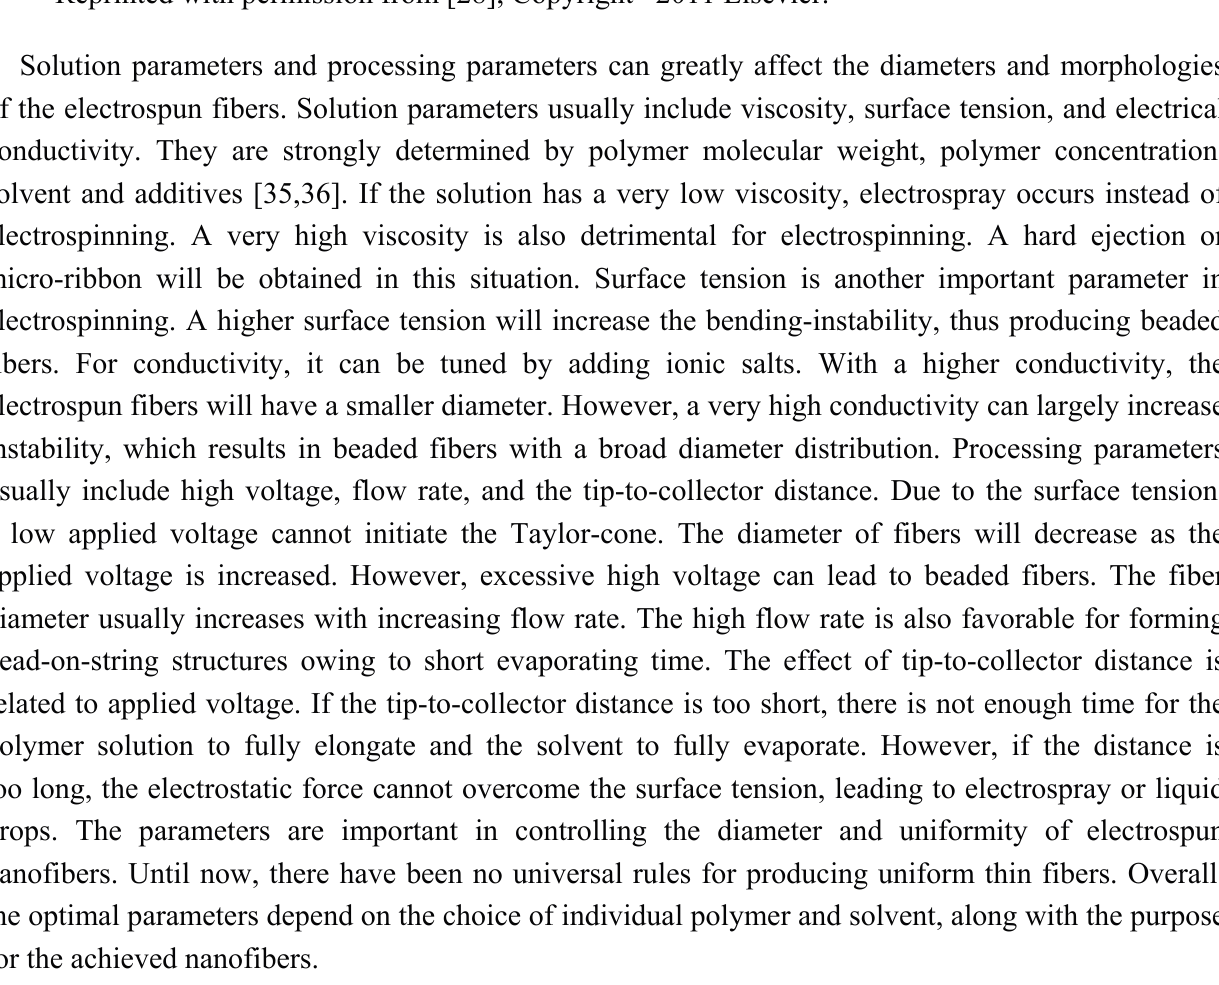
Figure 1. Electrospinning setup with ( a ) flat stationary collector; ( b ) rotating disc collector. Reprinted with permission from [28], Copyright © 2011